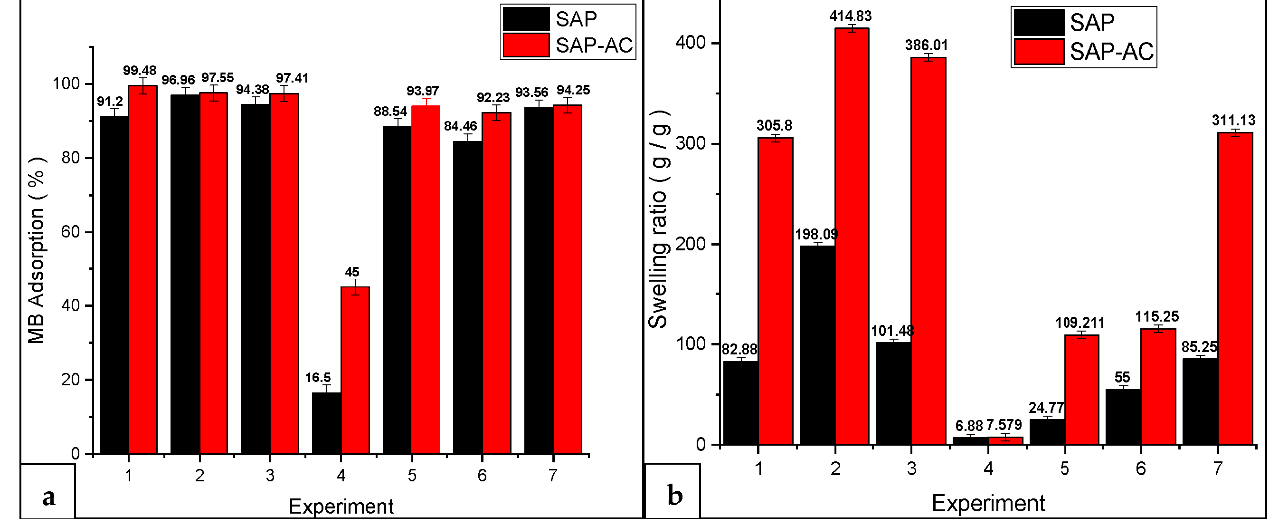
Figure 8. Comparison of various reaction parameters using SAP and SAP-AC for ( a ) percent MB adsorption and ( b ) swelling ratio.